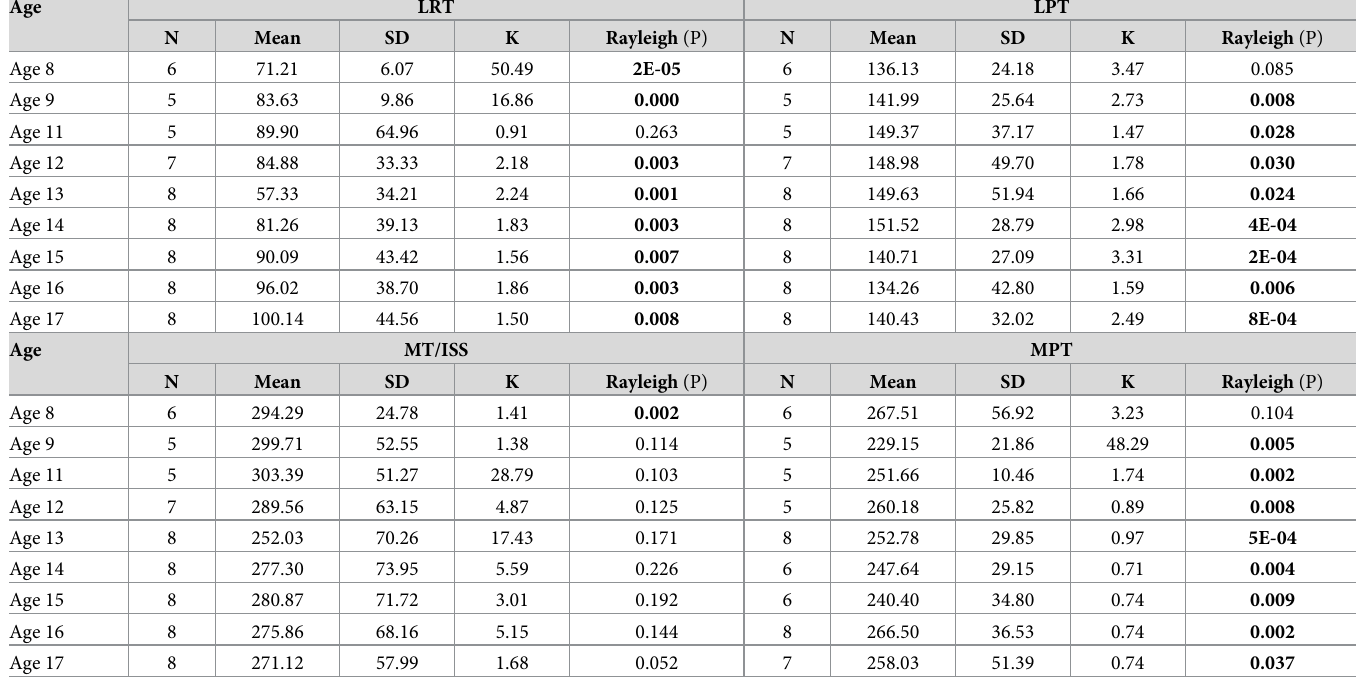
Table 4. Descriptive circular statistical analysis of wear contact directions, including the circular mean, the circular standard deviation (SD), the concentration parameter ( κ ), and the Rayleigh